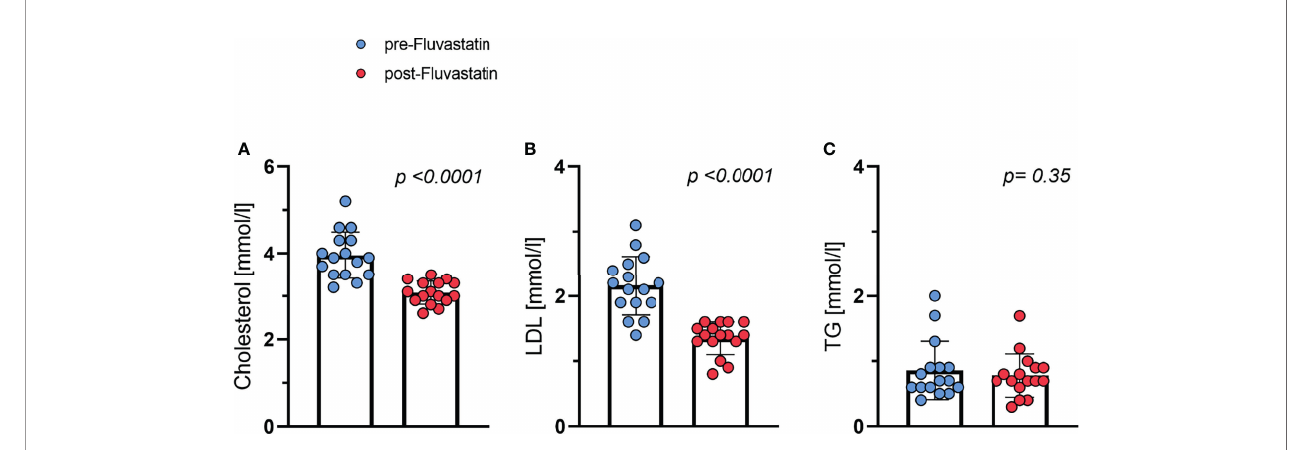
FIGURE 2 | Effect of fl uvastatin treatment on serum lipid levels. (A) Total cholesterol p < 0.0001 (B) LDL-cholesterol p < 0.0001 (C) Triglycerides (TG) p